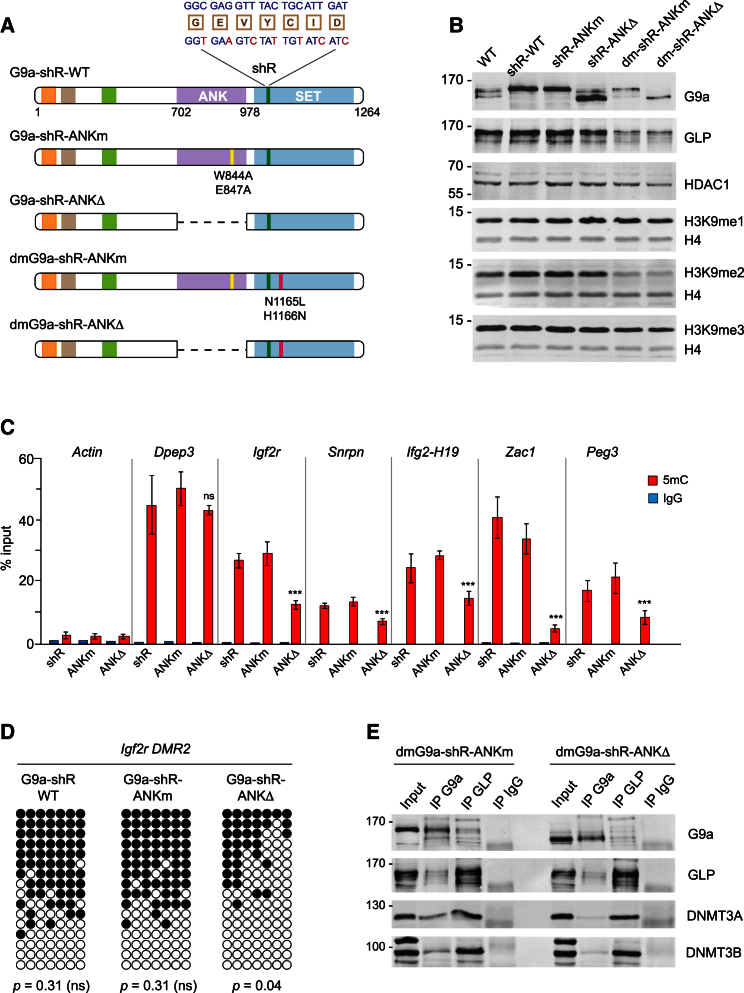
The ANK Domain of G9a and the Dimerization between G9a and GLP Are Required for Maintenance of Imprinted DNA Methylation(A) Schematic of shRNA-resistant (shR) wild-type and mutant forms of G9a. Silent mutations in shRNA targeted site (green) and point mutations disrupting either binding to H3K9me1/me2 (ANKm - yellow) or disrupting the dimerization of G9a with GLP (dm - red) are indicated. The dashed line represents ANK domain deletion (ANKΔ).(B) Protein levels of shRNA resistant wild-type and mutant G9a proteins in stable cell lines after knockdown of the endogenous G9a. Note that GLP and G9a are unstable, and H3K9me2 is reduced in cell lines expressing dimerization-deficient forms of G9a.(C) MeDIP detects reduced DNA methylation at ICRs in cells expressing G9a lacking the ANK domain (shR-ANKΔ). The error bars represent SD; n = 3; ∗∗∗p < 1e-3, ns p > 5e-2 (Mann-Whitney-Wilcoxon test). See also Table S1.(D) Bisulfite DNA sequencing of Igf2r ICR in cell lines expressing shR forms of G9a confirms the MeDIP data. p values were determined by chi-square test.(E) Detection of DNMTs by western blot in immunoprecipitations with anti-G9a or anti-GLP antibodies or mouse IgG from nuclear extracts of cells expressing dimerization-deficient G9a with either mutated (dm-shR-ANKm) or absent (dm-shR-ANKΔ) ANK domain.See also Figure S4.